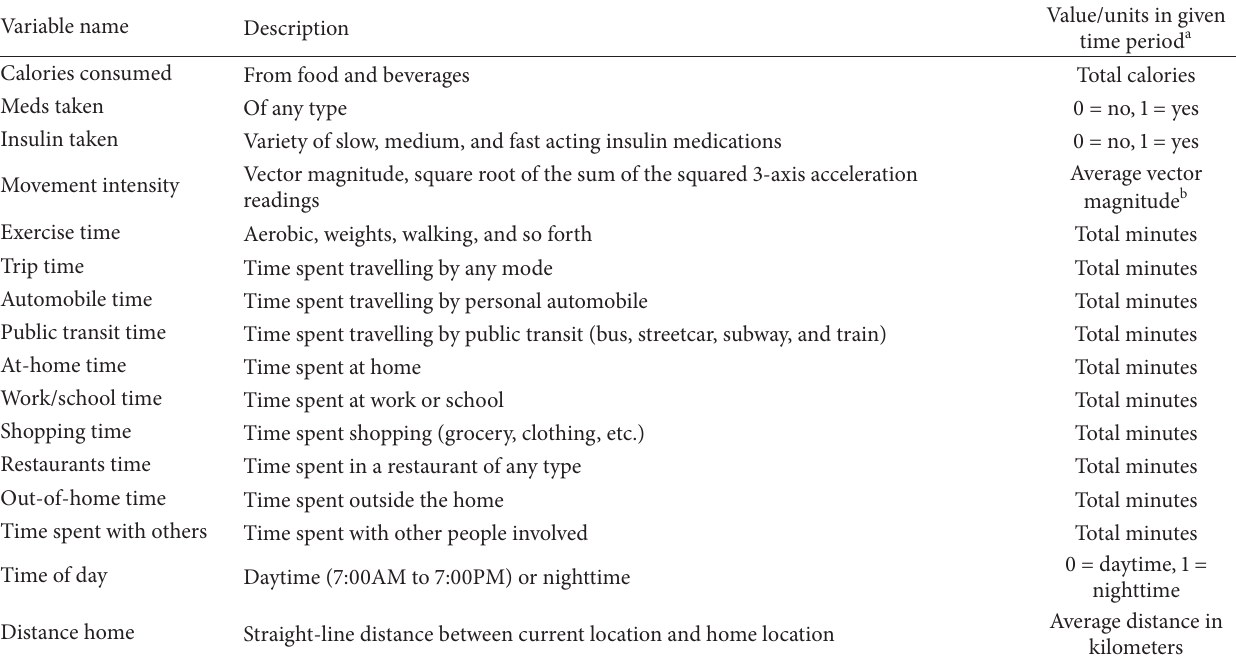
Table 1: Explanatory